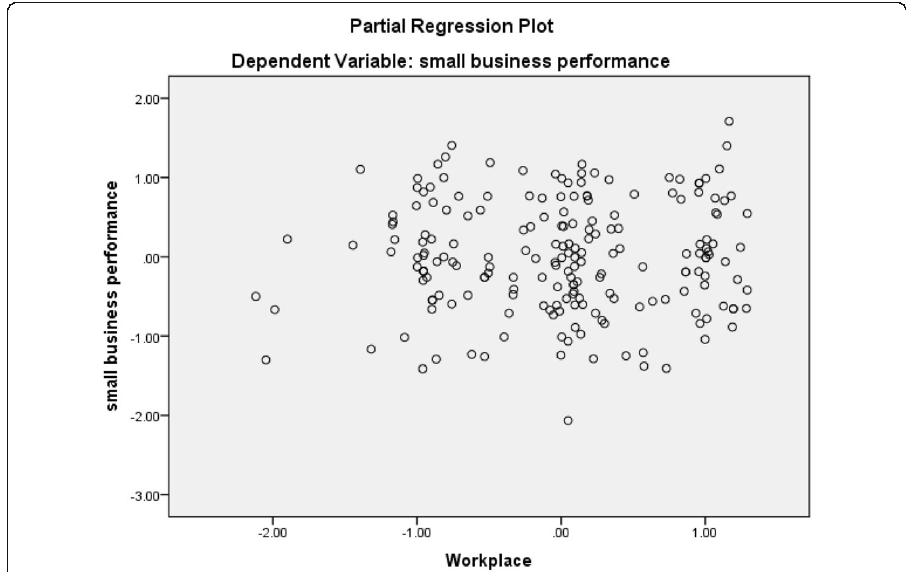
Fig. 6 Partial regression plot of independent variable